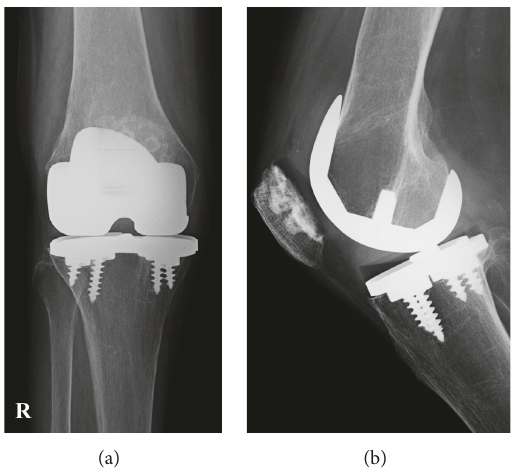
Figure 5: Follow-up plain radiograph obtained 17 years after initial surgery of the right-side implants shows normal alignment is maintained, with no evidence of stress shielding or